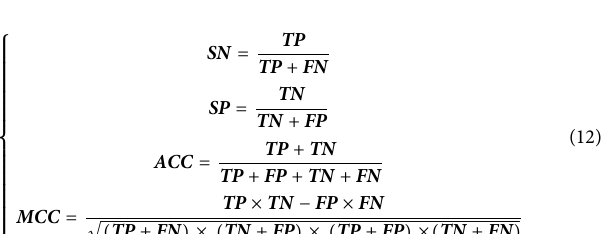
Figure 6 . Most of the membrane proteins in dataset 1 and dataset 2 have a similar length distribution because of their speci fi c type. membrane protein classi fi cation, we calculated the amino acid Figure 7 .